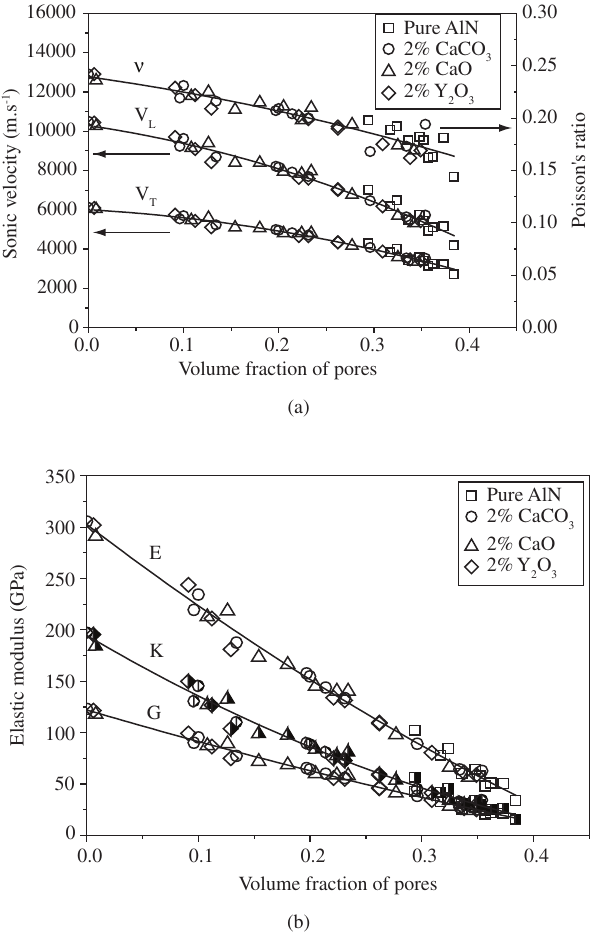
Figure 4. Results of: a) Longitudinal (V sintered at 3 Poisson’s ratio ( ν ); and b) Young’s (E), shear (G), and bulk (K) modulus. The O sintered at 1700 °C for 8 hours. In c), the 2 3 curves represent polynomial fit (Equation